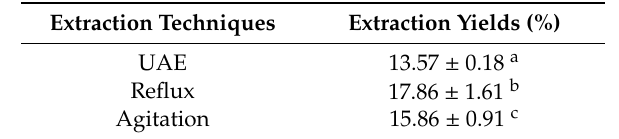
Table 1. Extraction yield of C. papaya leaves obtained by di ff erent extraction techniques. UAE: ultrasonic-assisted